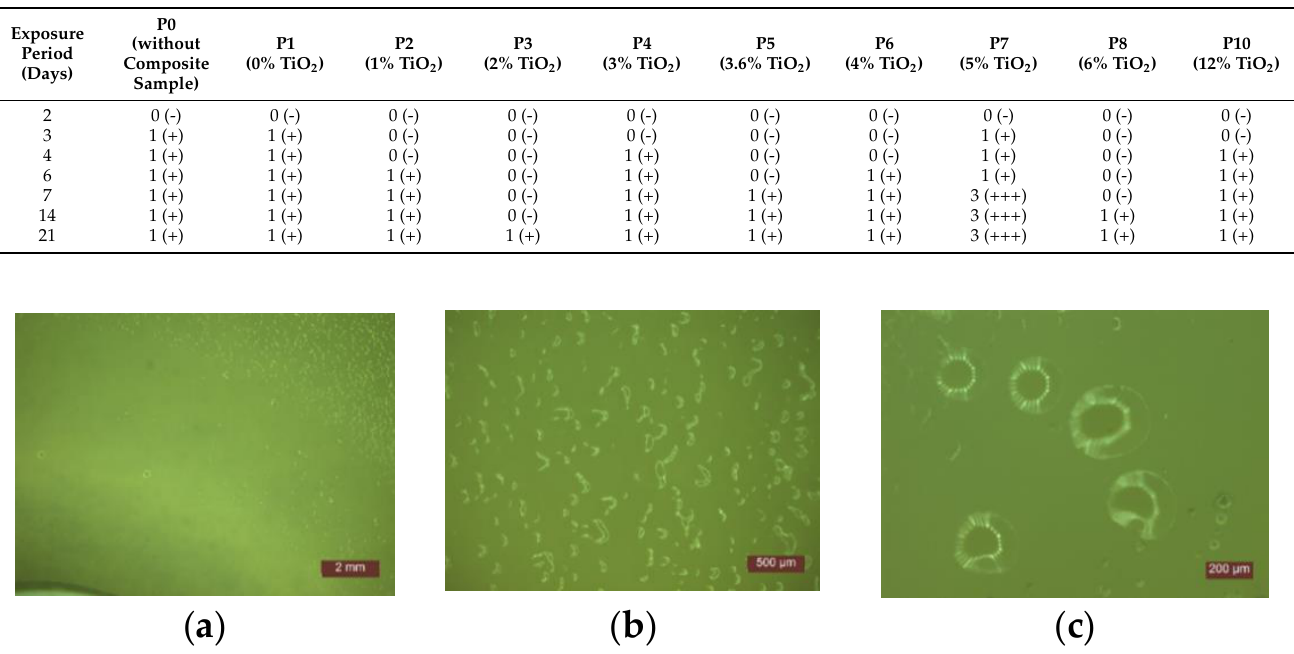
Table 5. Quantification of the microbiological load of the system according to STAS 12718 for samples exposed to Staphy- lococcus Aureus .